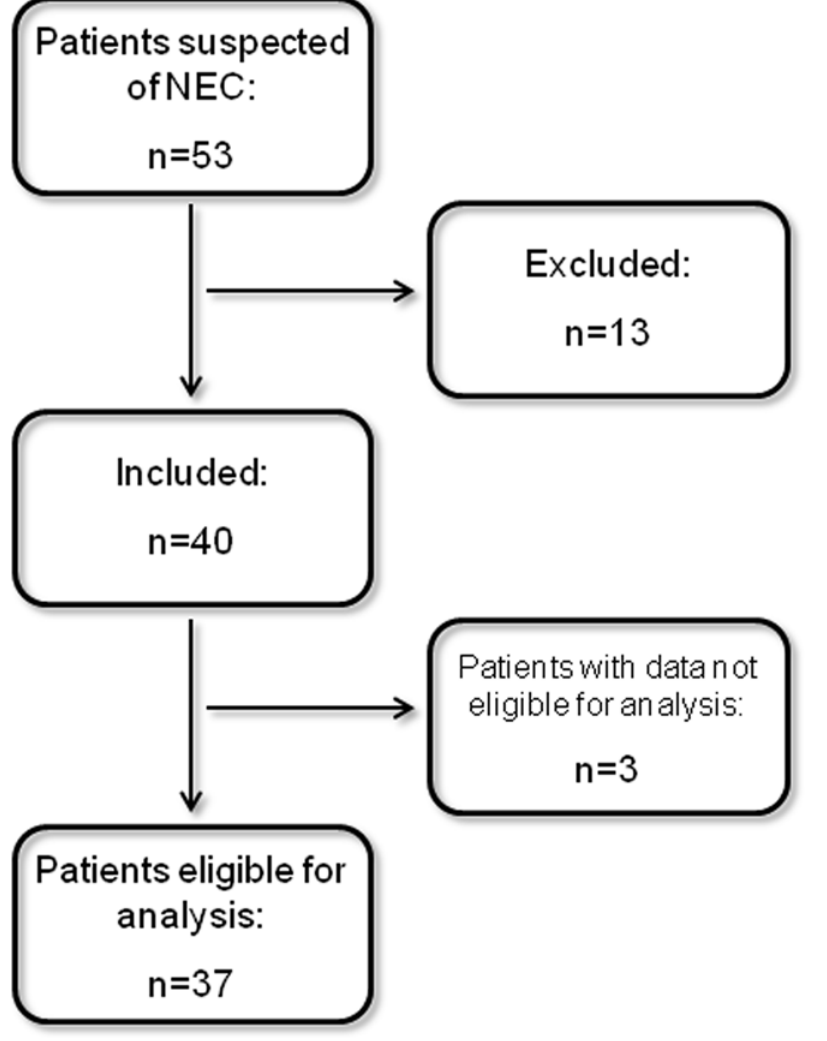
Fig 1. Flow chart of patient inclusion.